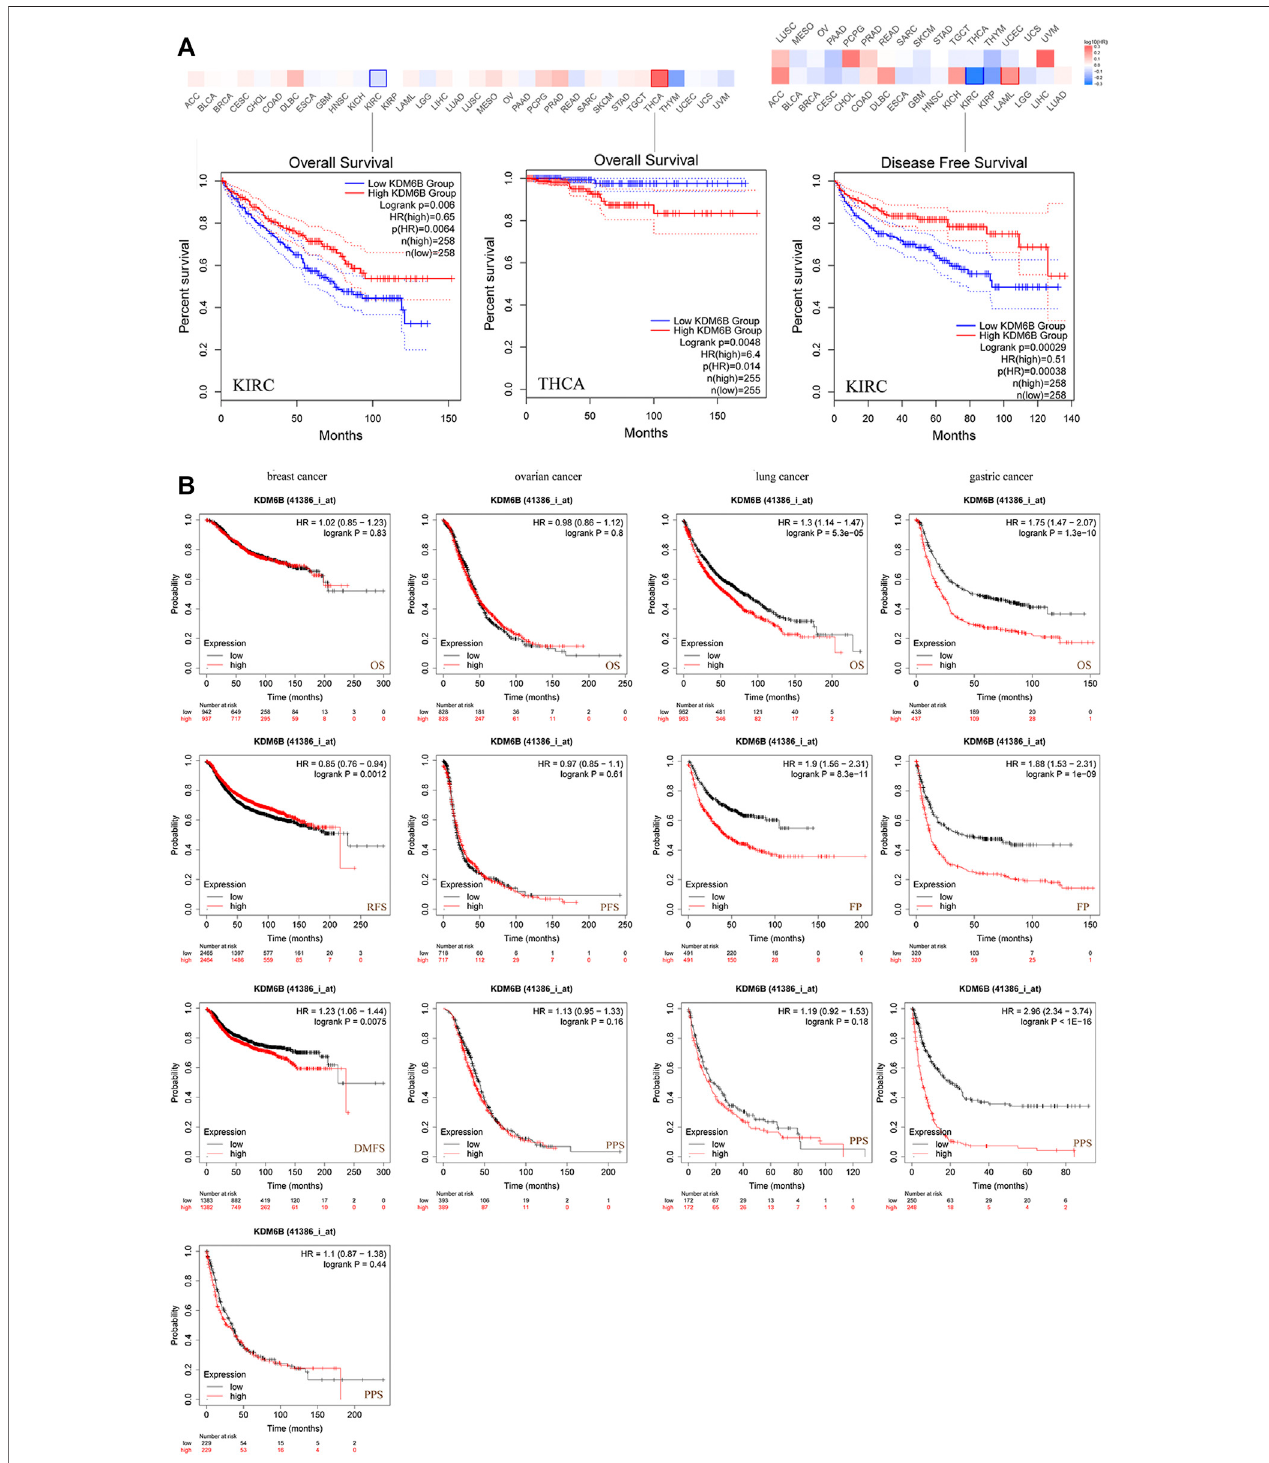
FIGURE 3 | Correlation between the KDM6B expression and survival prognosis of cancers in TCGA. (A) Using the GEPIA2 tool to perform overall survival and disease-free survival analyses of different tumors in TCGA with the KDM6B expression. (B) Using the Kaplan – Meier plotter to perform a series of survival analyses, including OS, DMFS, RFS, PFS, PPS, and FP via the expressions of KDM6B in breast cancer, ovarian cancer, lung cancer, and gastric cancer cases.